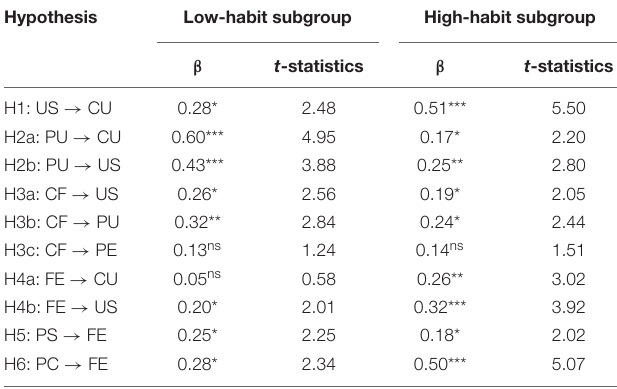
TABLE 2 | Results of path coefficients for